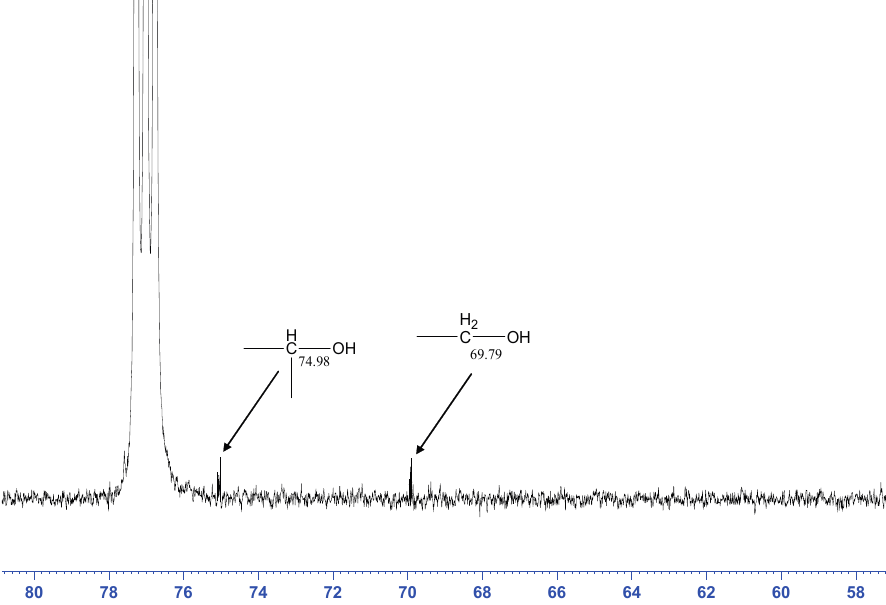
Figure 7. 13 C NMR of LNR prepared in acidic medium.